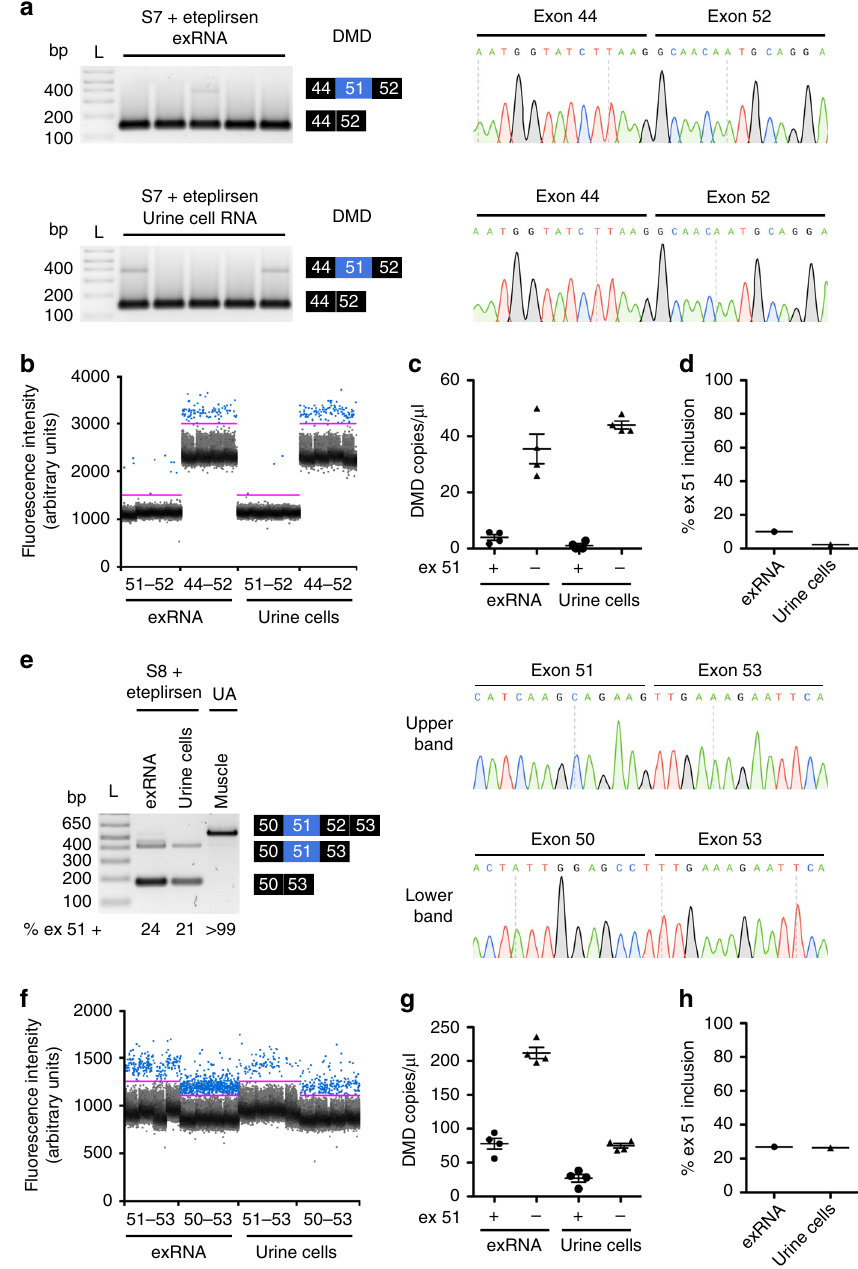
Fig. 10 Pharmacologic exon skipping activity of eteplirsen in human urine. Using RT-PCR and ddPCR, we examined urine exRNA and urine cell RNA in two non-ambulatory individuals with DMD who have been treated with 30 mg/kg eteplirsen weekly for ~3 years. a Left, using RT-PCR and primers targeting exons 44 and 52, two bands are identi fi ed in urine exRNA and urine cell total RNA ( N = 5 replicates each) from a non-ambulatory 17 year-old DMD patient (S7) with an exon 45 – 50 deletion. Right, sequencing of the lower-band PCR product. b ddPCR analysis of urine exRNA and urine cell total RNA ( N = 4 replicates each) from S7 using separate probe sets that are speci fi c for DMD transcripts with exon 51 included (51 – 52) or skipped (44 – 52) 35 . c Individual data points indicate quanti fi cation of DMD splice products in urine exRNA and urine cell total RNA ( N = 4 replicates each) that have exon 51 included ( + ) or skipped ( − ) as copies per microliter of cDNA. d Calculation of percent exon 51 inclusion in urine exRNA and urine cells using the data in c . e Left, using RT-PCR and primers targeting exons 49 and 53, two bands are identi fi ed in urine exRNA and urine cell total RNA from a non-ambulatory 19 year-old DMD patient (S8) with an exon 52 deletion. UA muscle tissue RNA served as a control. Right, sequencing of the urine exRNA PCR products. f ddPCR analysis of urine exRNA and urine cell total RNA ( N = 4 replicates each) from S8 using separate probe sets that are speci fi c for DMD 52 deletion transcripts with exon 51 included (51 – 53) or skipped (50 – 53) 35 . g Individual data points indicate quanti fi cation of DMD splice products in urine exRNA and urine cell total RNA ( N = 4 replicates each) that have exon 51 included ( + ) or skipped ( − ) as copies per microliter of cDNA. h Calculation of percent exon 51 inclusion in urine exRNA and urine cells using the data in ( g ). All error bars indicate mean ±